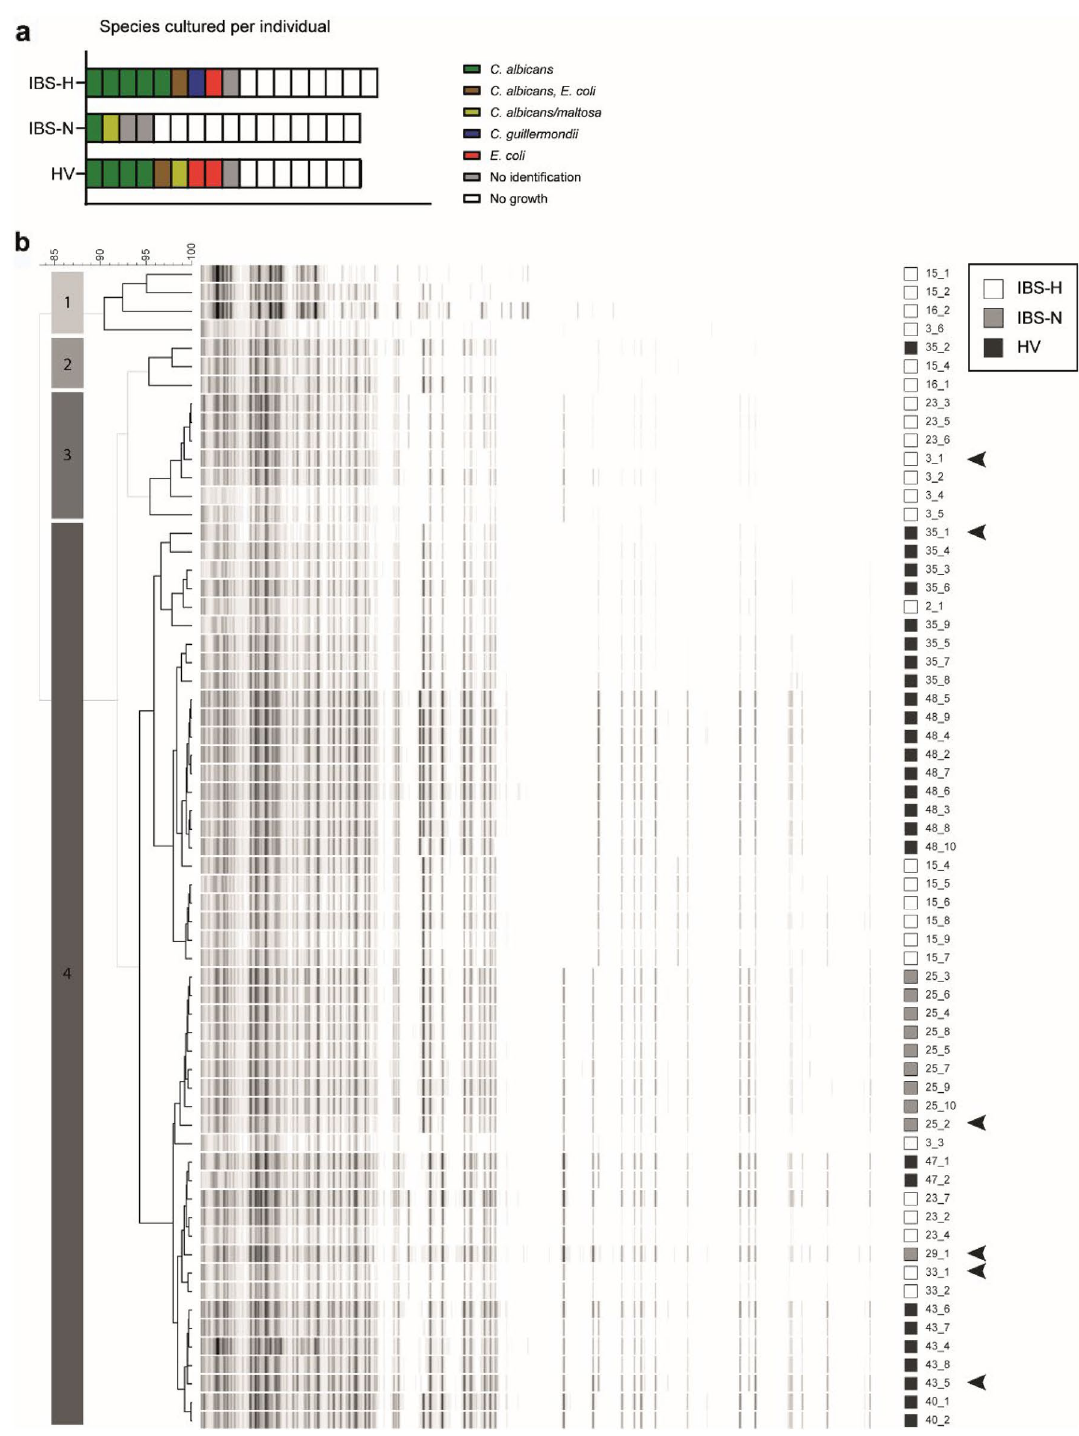
Figure 2. Culture of fecal samples yields genetically diverse C. albicans strains. ( a ) Cultured species from fecal samples as determined by MALDI-TOF MS analysis. Each rectangle indicates one patient sample. ( b ) Amplified Fragment Length Polymorphisms (AFLP) fingerprint analysis of 63 C. albicans strains reveals genetic differences as reflected in varying fingerprint patterns. Colored squares indicate sample group origin of the strain, composed numbers identify fecal sample and strain number respectively. Dendrogram shows clustering of strains into 4 groups at 90% similarity. Arrowheads indicate strains selected for follow-up phenotypic examination. IBS-H hypersensitive IBS patients, IBS-N normosensitive IBS patients, HV healthy